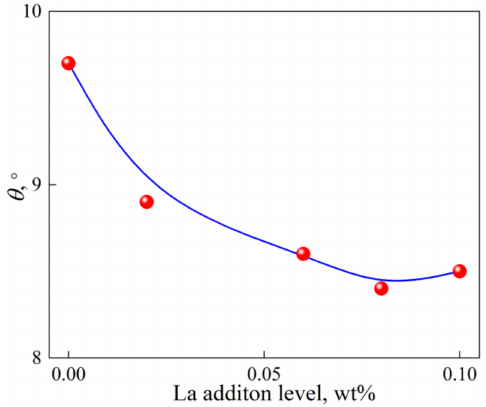
Figure 8. Calculated contact angle θ varied with trace La addition